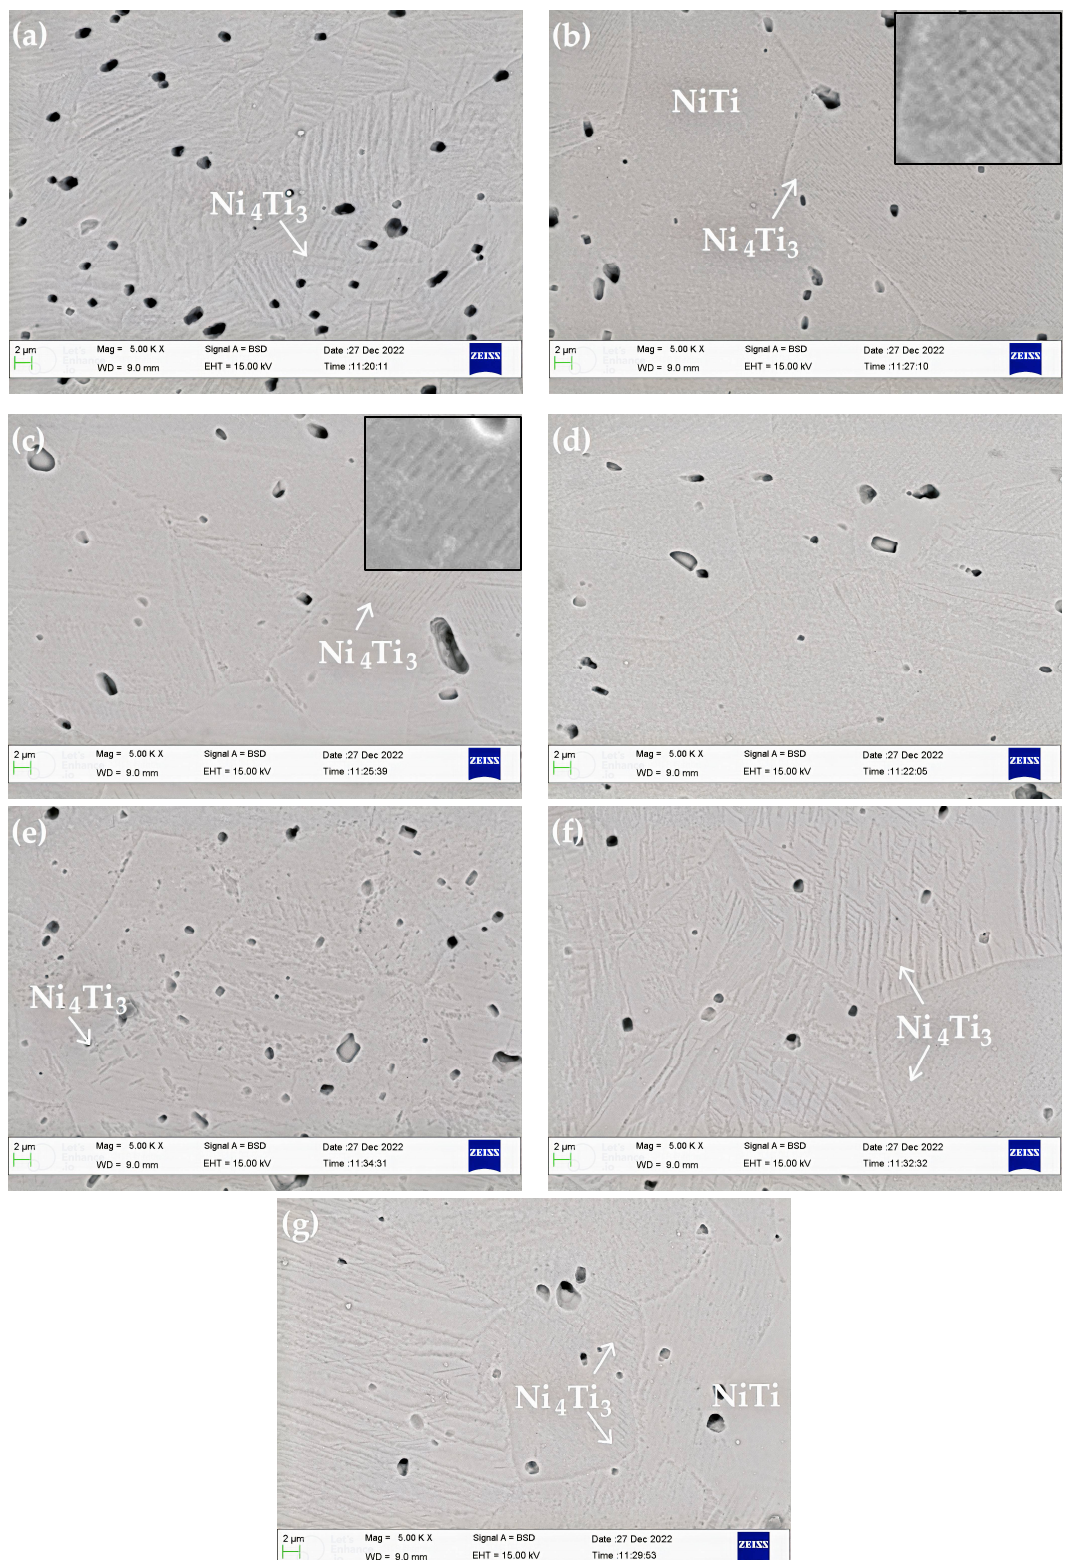
Figure 7. SEM images of NiTi archwires: ( a ) AR archwire, ( b ) aged at 370 °C, ( c ) aged at 400 °C, ( d ) aged at 430 °C, ( e ) aged at 460 °C, ( f ) aged at 490 °C, and ( g ) aged at 520 °C.